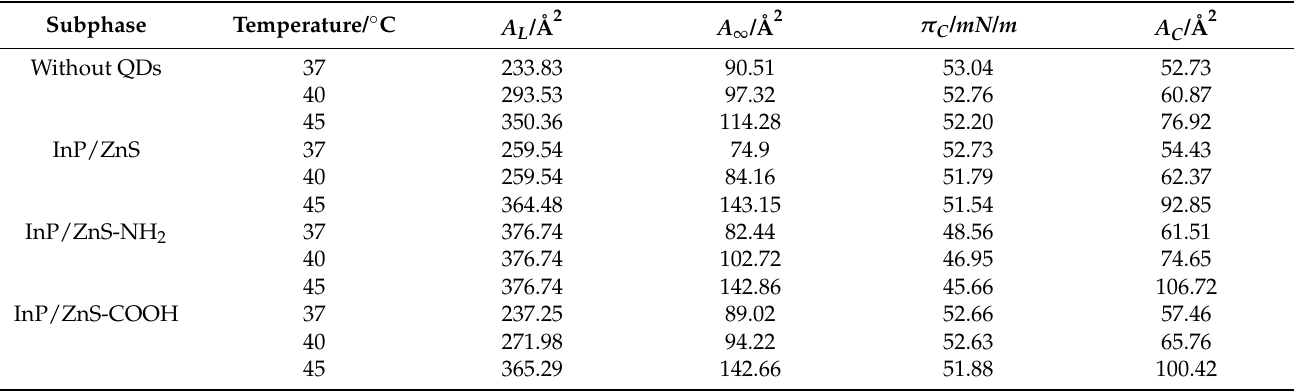
Figure 1. The surface pressure–mean molecular area ( π − A ) isotherms and the C − 1 s − π curves (insert images) of the DPPC/DPPG mixed monolayer on the air–water interface in the absence of QDs ( A ) and in the presence of InP/ZnS ( B ), InP/ZnS-NH 2 ( C ) and InP/ZnS-COOH QDs ( D ). Table 1. The three characteristic parameters and A C values at various temperatures on the surface of different subphase solutions a From Table 1, the 𝐴 𝐿 value of the DPPC/DPPG mixed monolayer increases as the